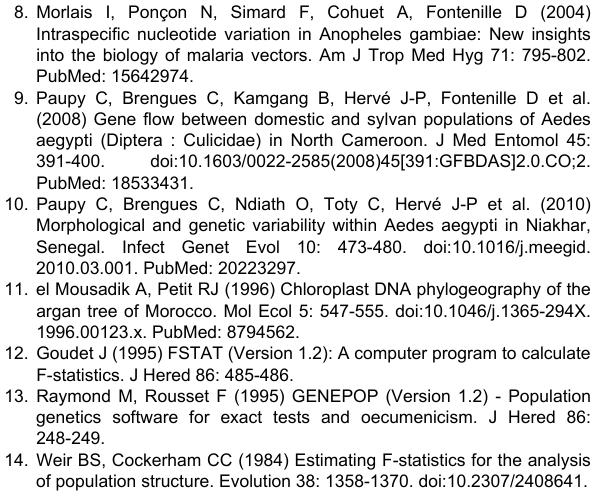
Table S3. Comparison of pairwise Fst obtained with microsatellites and SNPs for six populations of Martinique.